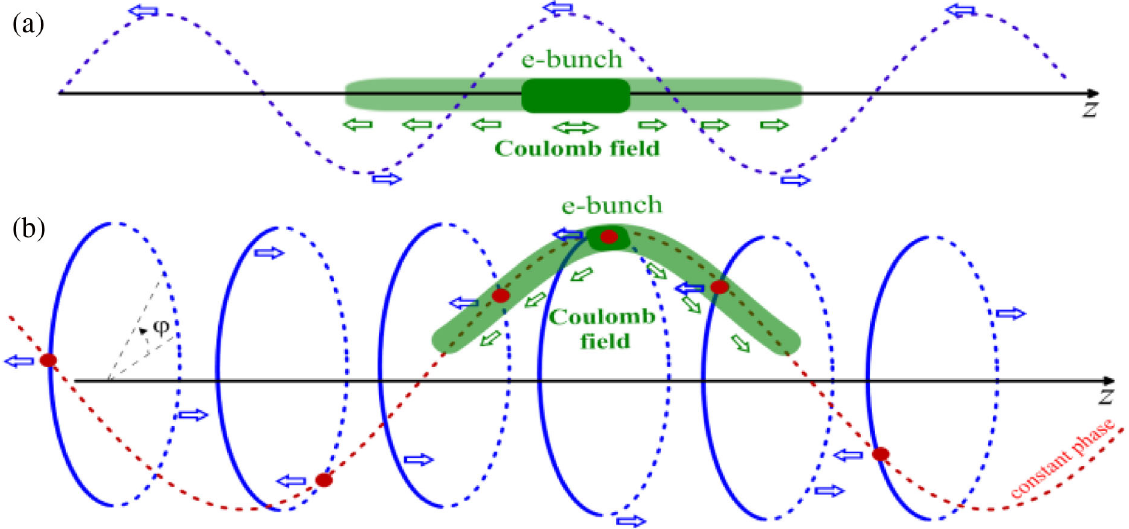
center.FIG. 3. (a) In the case of either ubitron or Cherenkov masers, axial expansion of the bunch leads to an increase in the bunch phase size with respect to the radiated wave. (b) In the cyclotron maser, the bunch is stretched along the 2D helix of the constant electron phase with respect to the